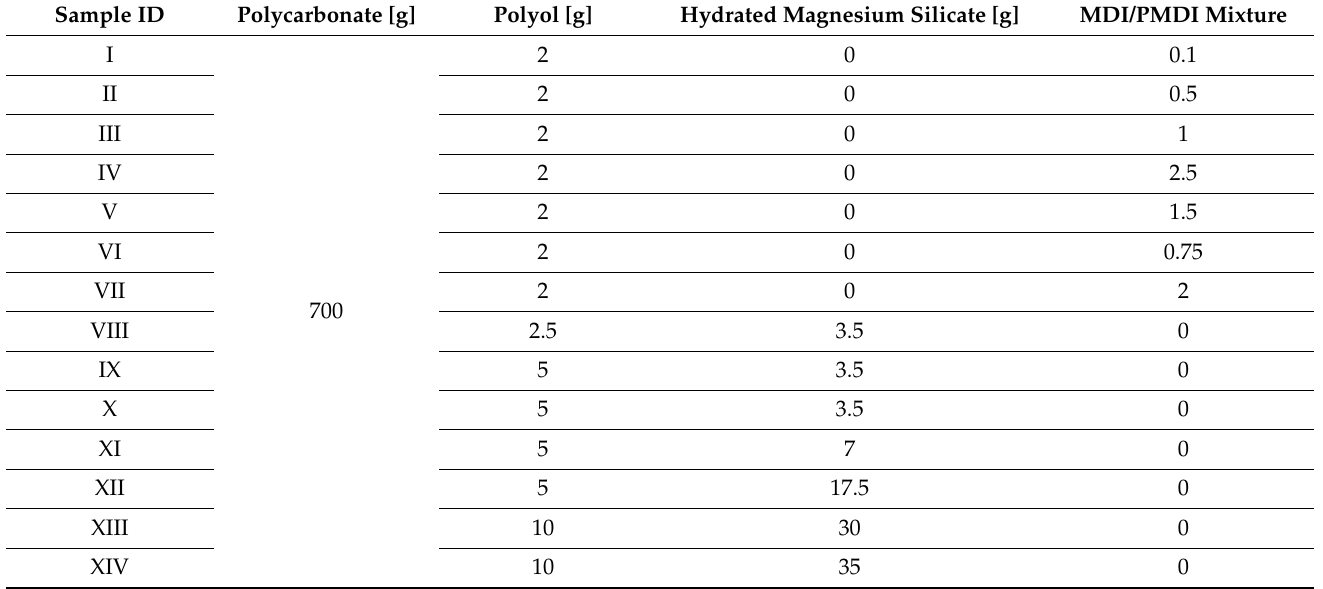
Table 1. Compositions of the analyzed